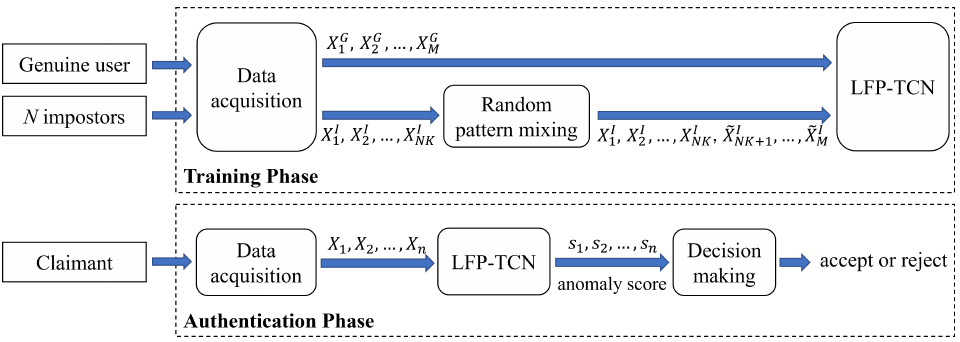
Figure 1. Framework of our authentication